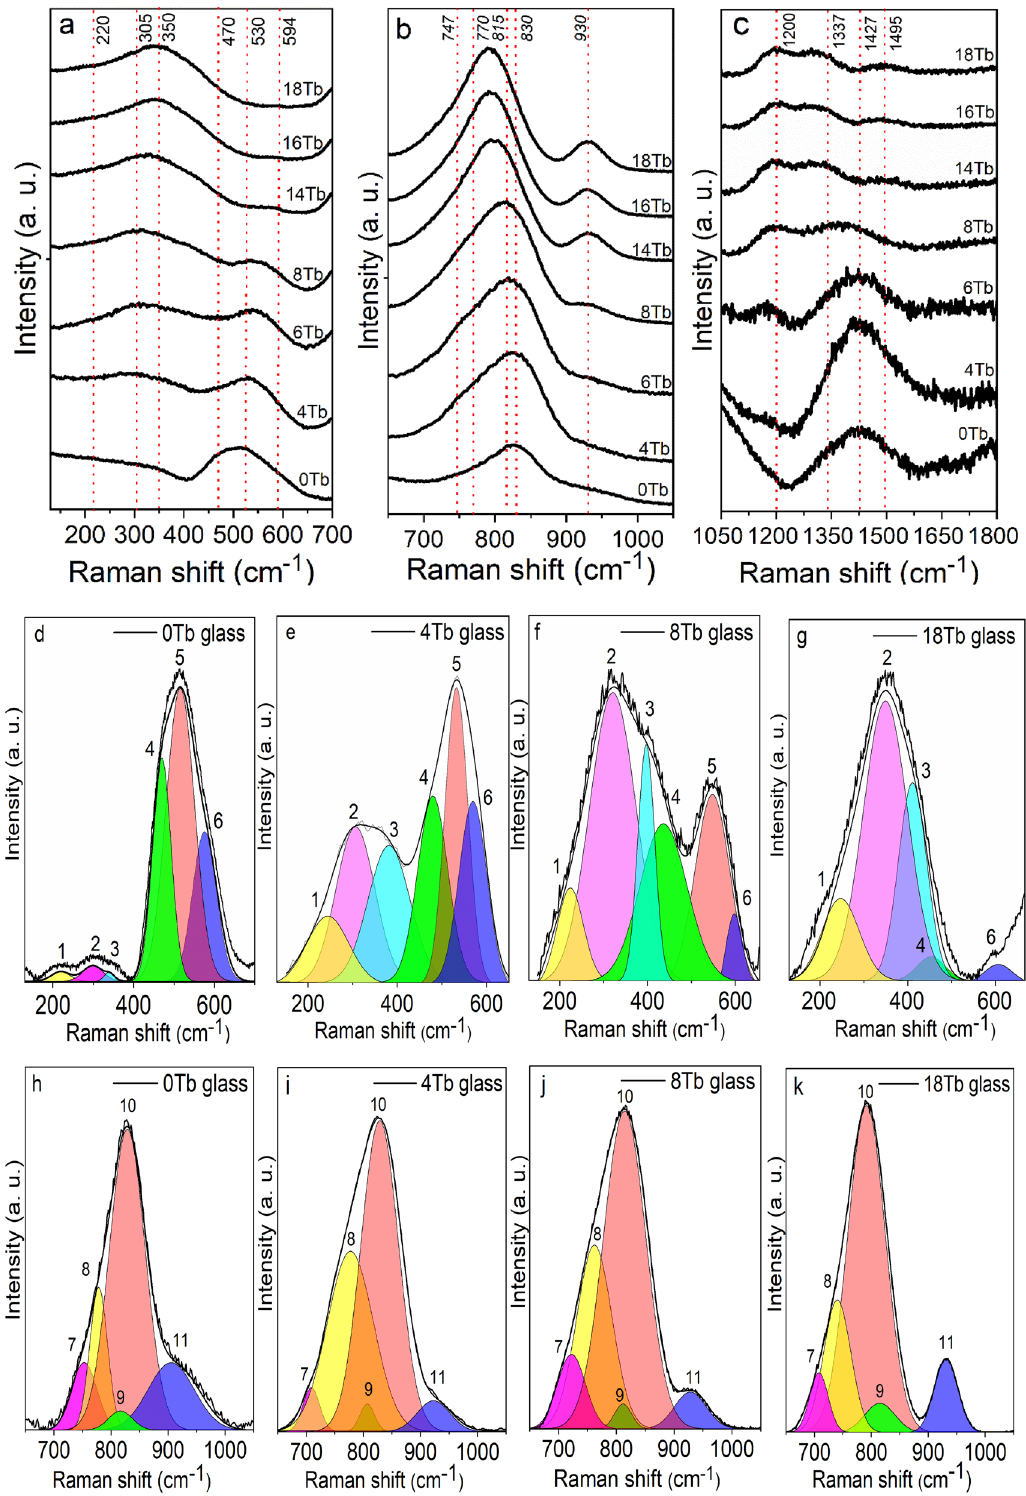
Figure 5. Normalized Raman spectra for the BGB- x Tb glasses in ( a ) low (~ 130–650 cm −1 ), ( b ) medium (~ 650–1050 cm −1 ), and ( c ) high (1050–1700 cm −1 ) frequency regions. Deconvolution of the Raman spectra for the 0, 4, 8, and 18 Tb glasses in the low ( d – g ), medium ( h – k ), and high ( l – o ) frequency